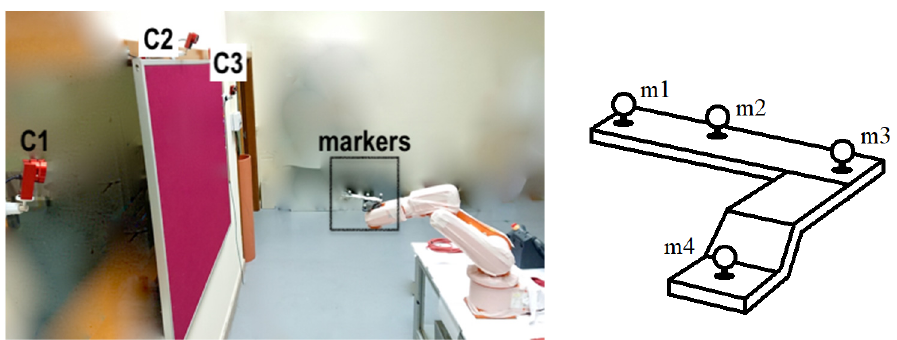
Figure 3. The experimental evaluation procedure: an L-shaped set of markers are moved by the robot in the workspace.